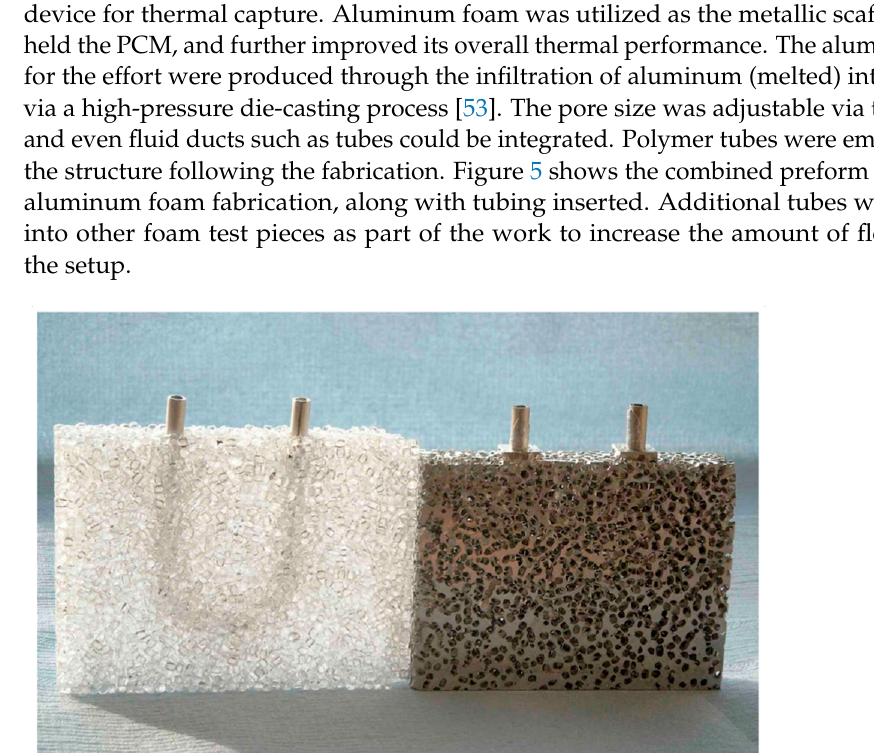
Figure 5. Use of supporting foams utilized for PCM investigations, including pass-through tubing for working fl uid thermal exchange [52]. The PCM selected for this e ff ort was a para ffi n based RT18HC from Rubitherm Technologies GmbH. The initial latent heat of fusion was 230 J/g, with a phase change point of 18 °C [53]. To maintain form stability in the PCM, a thickening agent (10% polybutadiene-based) was added to melted PCM prior to foam insertion. Aluminum foams were then fi lled with PCM via a vacuum process. The authors investigated both